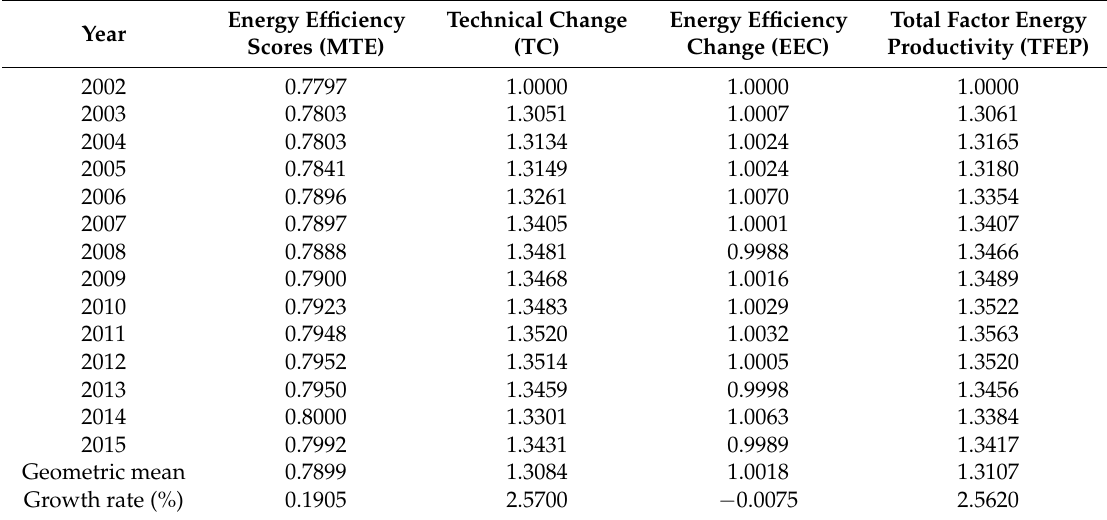
Table 7. Total factor energy productivity and its components of the gher farming system,